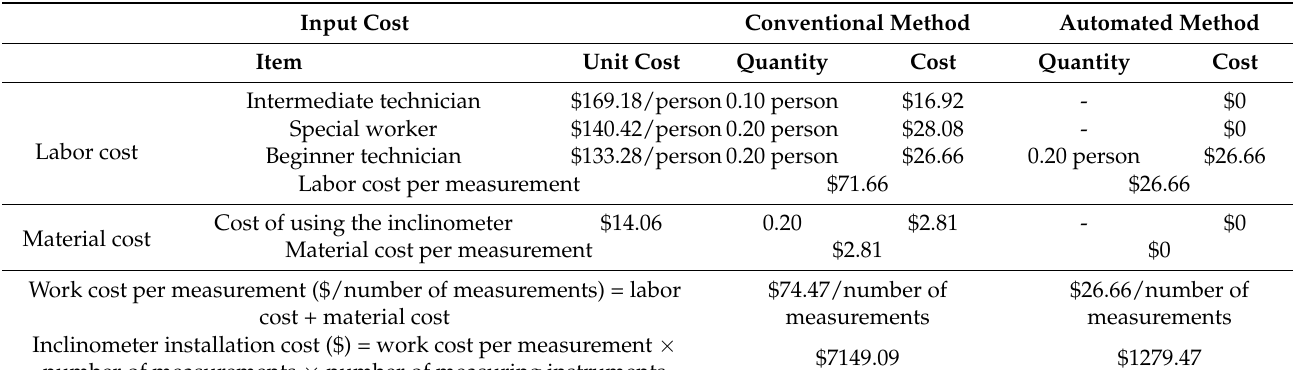
Table 7. Measurement costs for the conventional and automated methods.